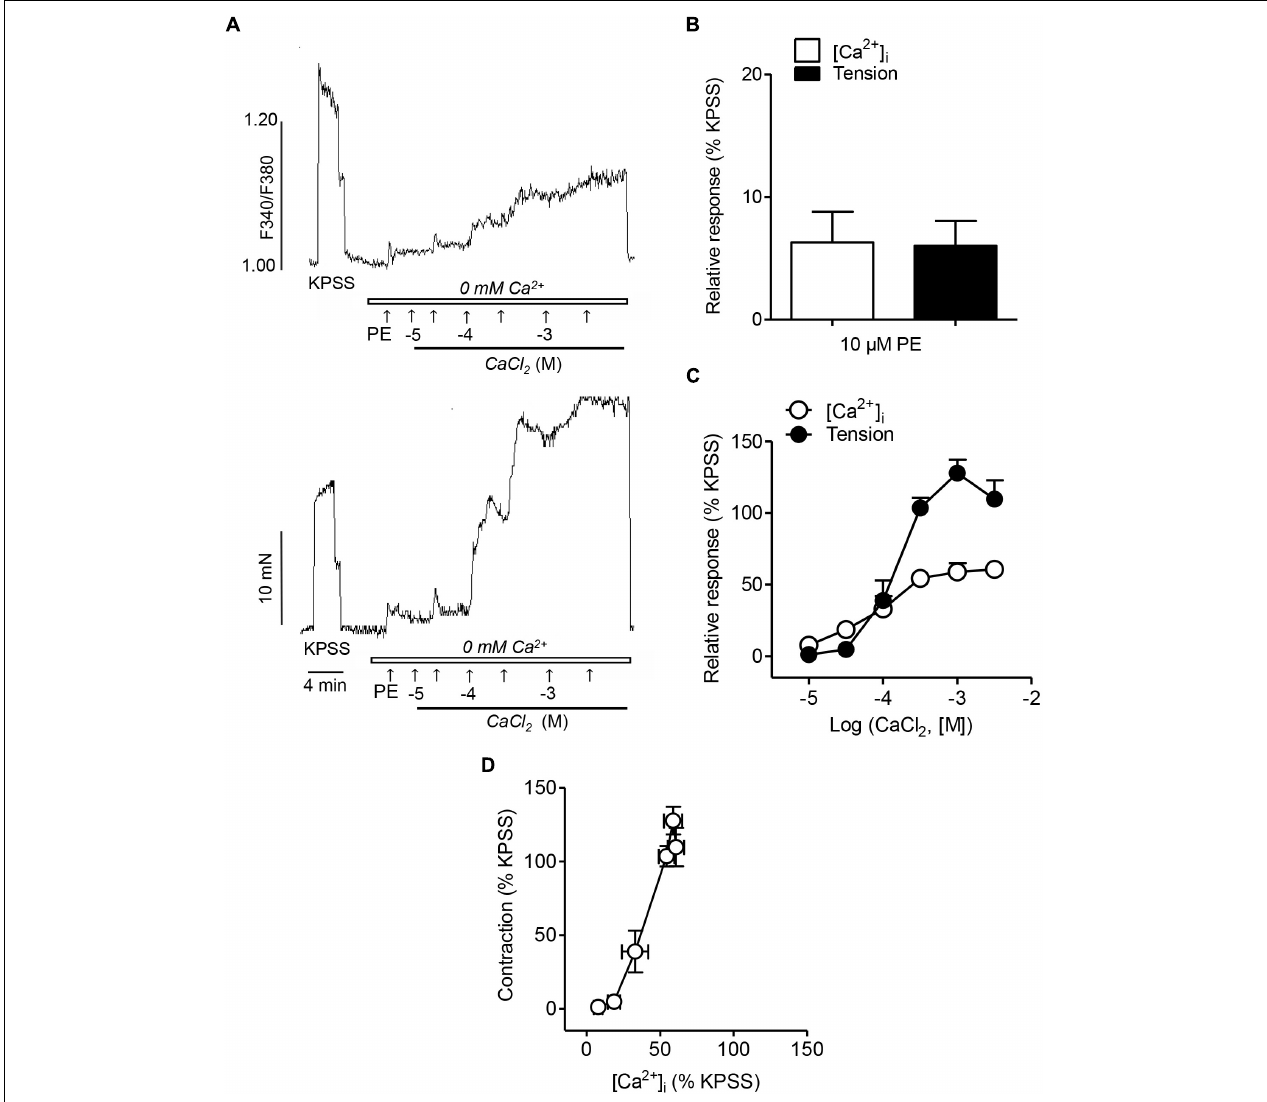
FIGURE 1 | α 1 -Adrenoceptor activation involves intracelular Ca 2 + mobilization, Ca 2 + entry and Ca 2 + sensitization associated to contraction (A) Representative traces illustrating the changes in both [Ca 2 + ] i mobilization (top) and vasoconstriction (bottom) induced by activation of α 1 -adrenoceptors by a single dose of Phenylephrine (PE) (10 µ M) and further cumulative addition of CaCl 2 (closed bar) in endothelium-denuded mesenteric arteries kept in nominally Ca 2 + -free medium (0 mM Ca 2 + , open bar). (B,C) Summarized data showing changes in [Ca 2 + ] i and vasoconstrictor responses stimulated by 10 µ M PE addition in arteries kept in nominally Ca 2 + -free medium (B) and further cumulative re-addition of CaCl 2 (C) . (D) Relationship between [Ca 2 + ] i -contraction in response to cumulative addition of Ca 2 + in arteries kept in Ca 2 + free medium and stimulated with 10 µ M PE. Responses are expressed as absolute values of either [Ca 2 + ] i ( (cid:49) F 340 / F 380 ) or tension (Nm − 1 ) (A) or relative to those elicited by KPSS (B–D) . Values are means ± SEM of n = 7 arteries (one from each